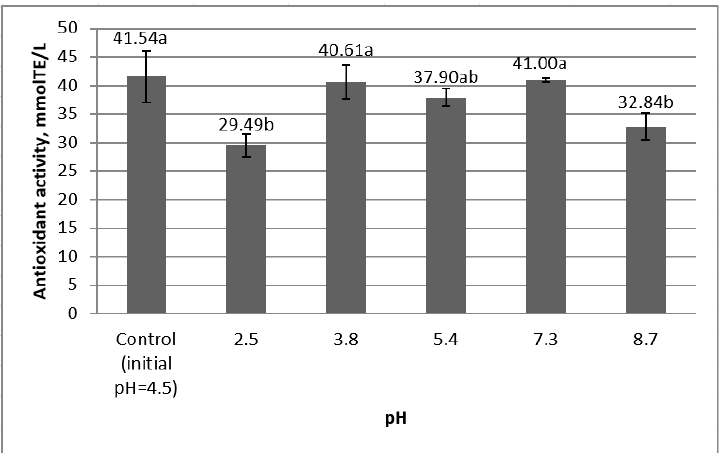
Figure 3. The dependence of antioxidant activity on pH (errors bars represent the standard deviation of three determinations; different letters (a,b) designate statistically different results ( p ≤ 0.05)).